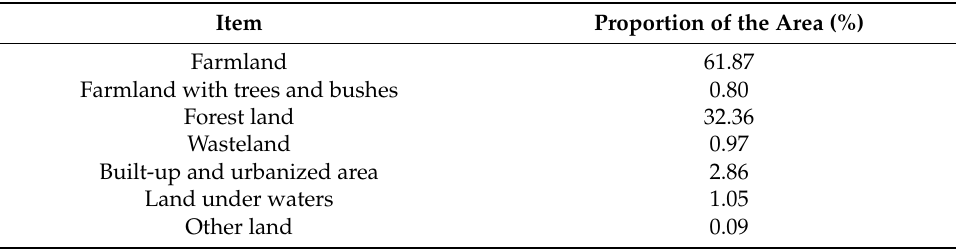
Table 1. Land use structure in the commune of Goworowo. Item Proportion of the Area (%) Farmland 61.87 Farmland with trees and